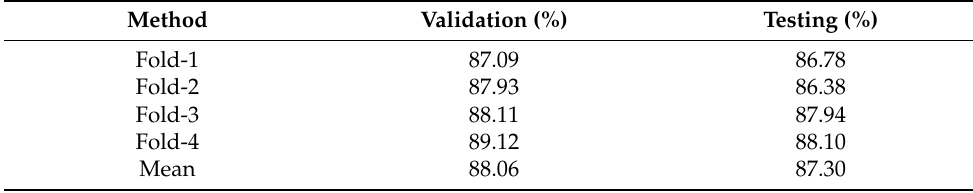
Table 8. Accuracy of four-fold